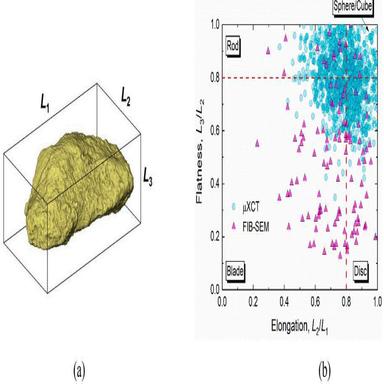
Particle shape. (a) Illustration of characteristic lengths of a loess particle, L1, L2 and L3 denote respectively the maximum, intermediate and minimum side lengths of the box just containing the particle. (b) Statistics of particle shape in terms of flatness (L2/L1) versus elongation (L3/L2) for particles extracted from μXCT and FIB-SEM.